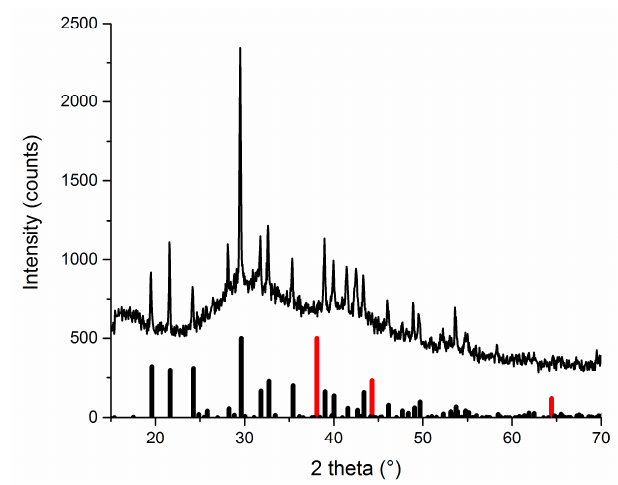
Figure 10. XRD pattern of the dried filtrate after washing of Ag:SER 1:1 sample (bars at the bottom refer to the records in ICDD PDF2 database: AgNO 3 (black, 074-2076), Ag (red, 65-2871).